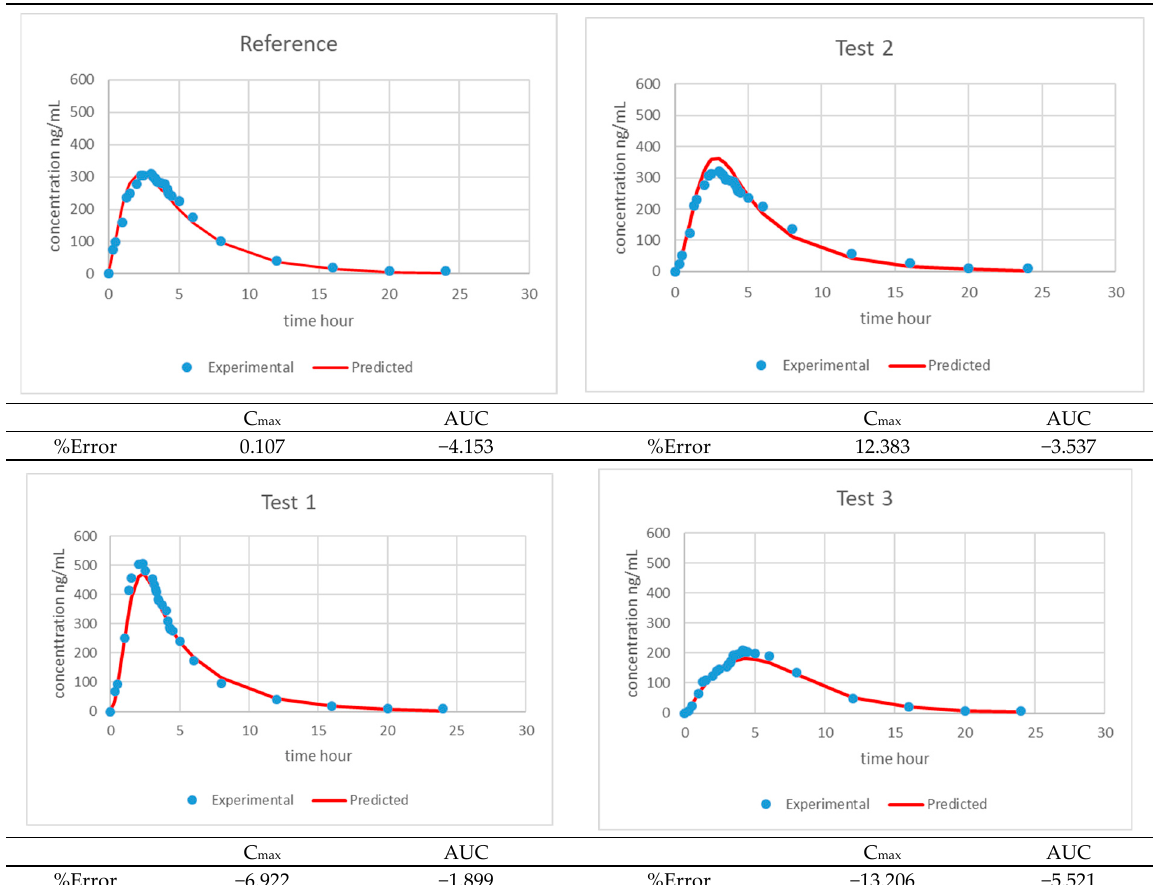
Figure 13. Predicted (solid line) and experimental (dots) montelukast plasma levels representing the one-step level-A IVIVC developed with 3 formulations. The AUC and Cmax internal prediction errors and the external prediction error for Test 2 are shown. Table 7. Parameters (and their standard error and coefficient of variation) of the IVIVC developed with 3 formulations.